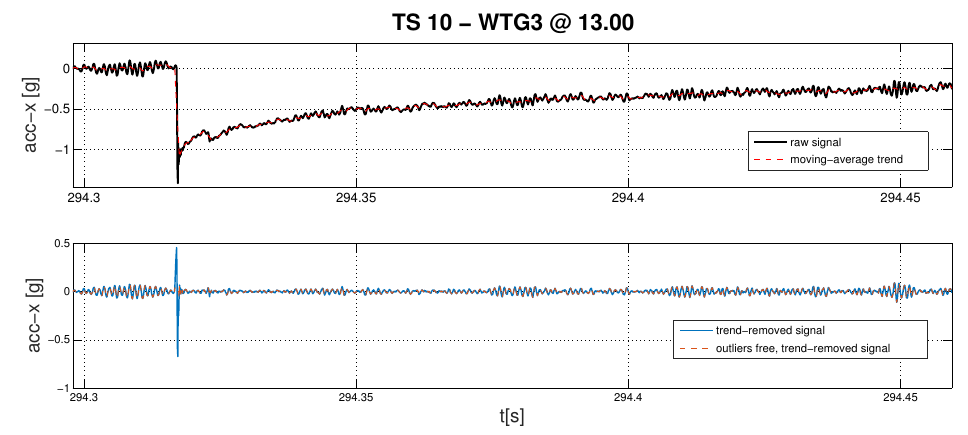
Figure 5. Zoom on a sample time series of the raw and processed